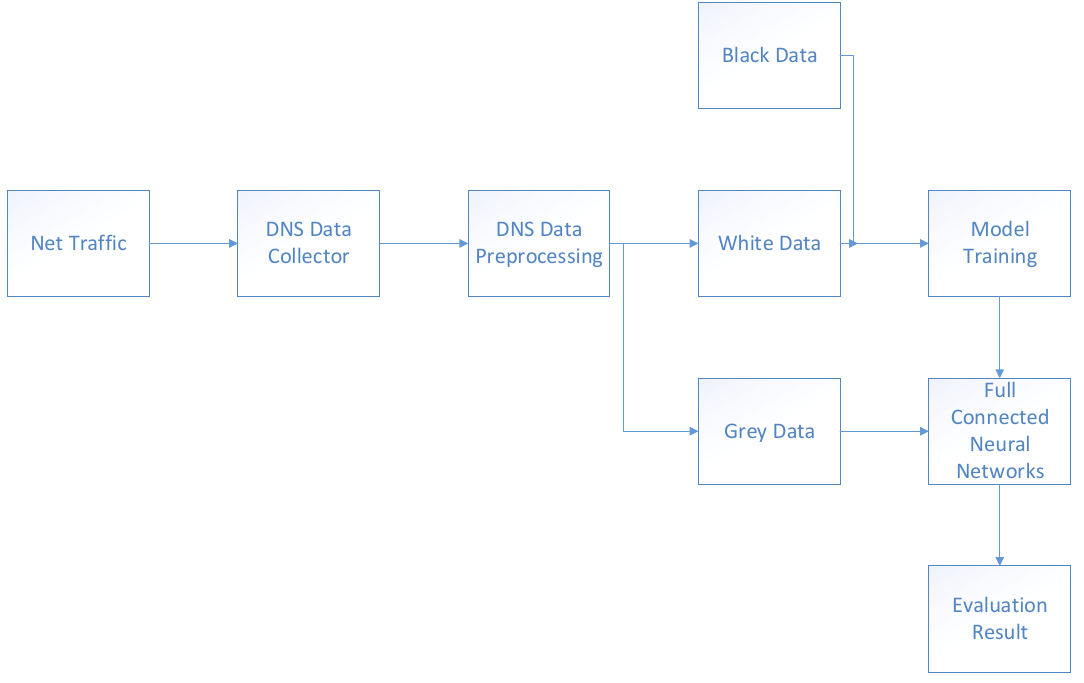
Figure 2. Architecture of the system. DNS = domain name